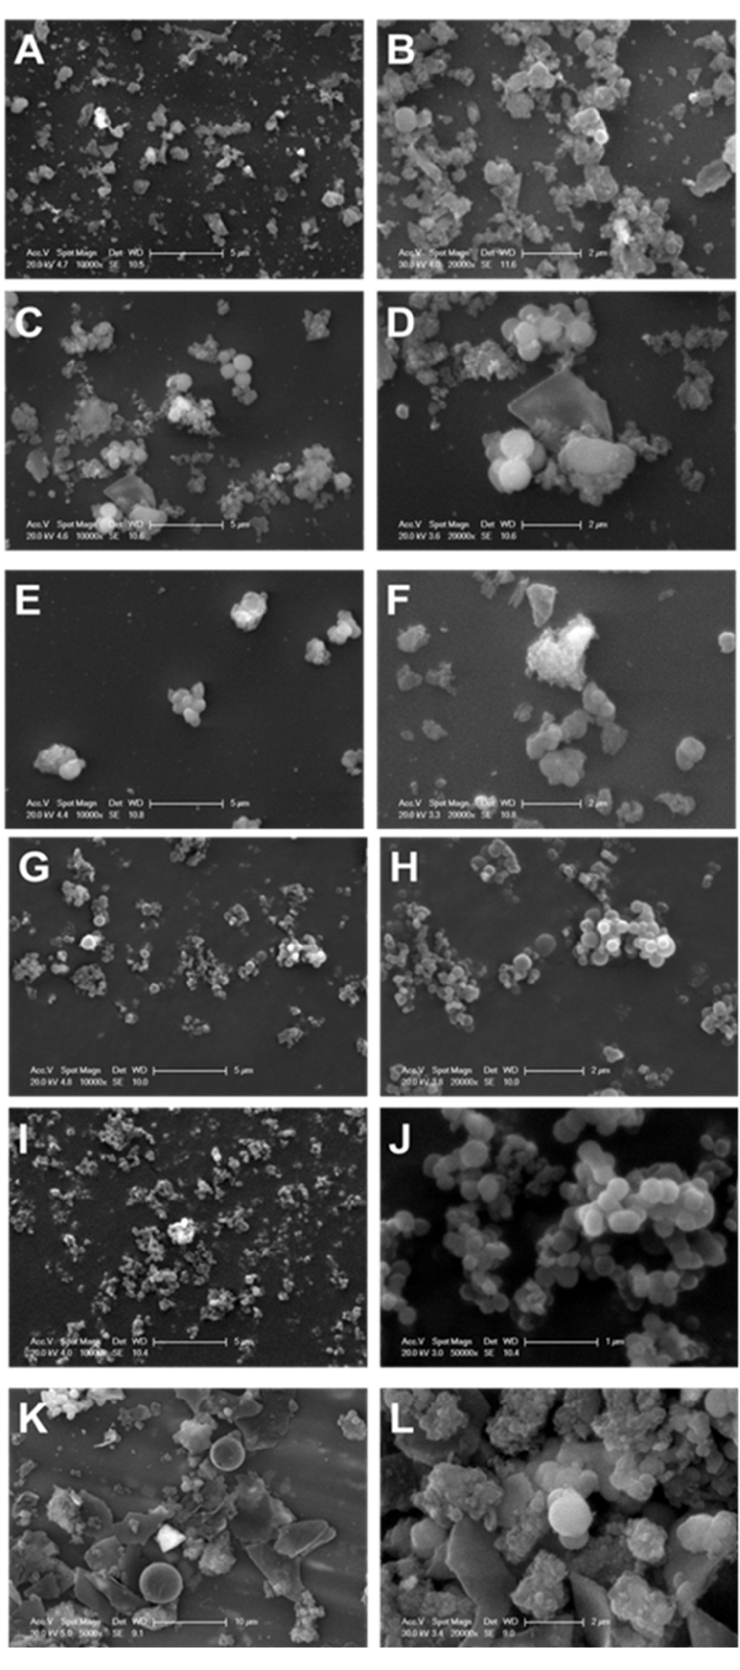
Figure 3. SEM images of the Fe 3 O 4 @MSN samples including FeNPs stabilised with oleic acid ( A , B ), palmitic acid ( C , D ), citric acid ( E , F ), butyric acid ( G , H ), CTAB ( I , J ), and APS ( K , L ). Fe 3 O 4 @MSNs were synthesized by means of the combination of Fe 3 O 4 NPs with the DSDA and water. The DSDA employed was NDLT (containing a hydrophobic chain of 10 carbon molecules). According to the above-mentioned study of the Fe 3 O 4 NP stabilisers, the selected reagents for such functionalisation were CTAB and butyric acid, named as